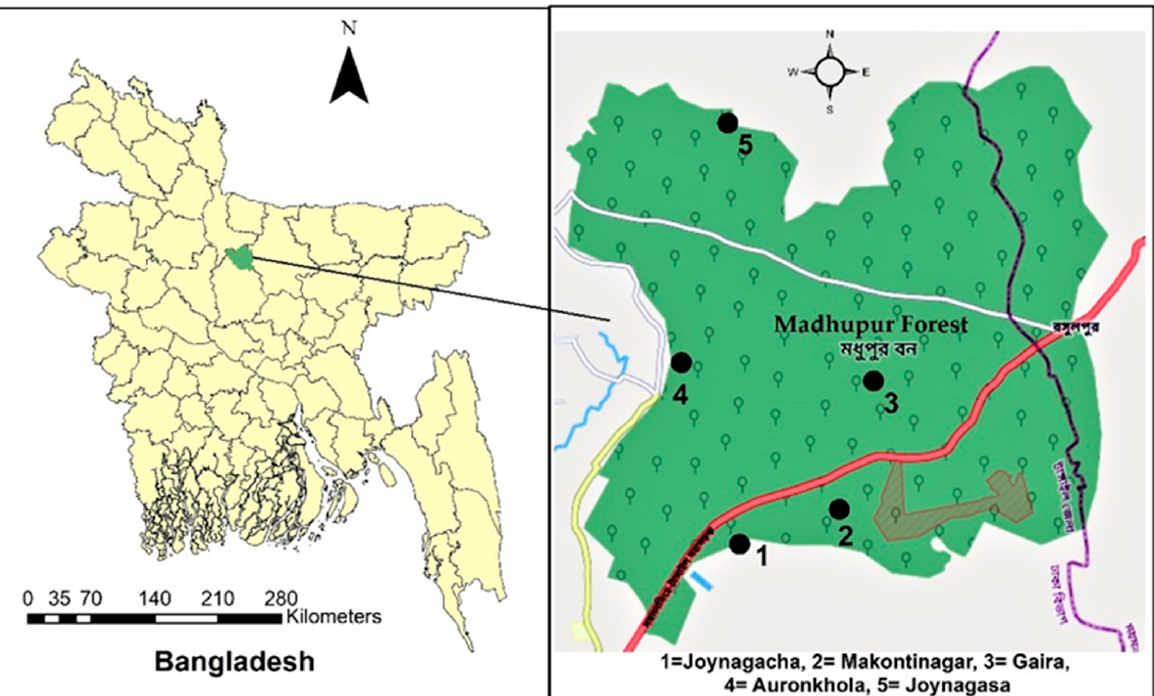
Figure 2. Study area map showing different villages of Madhupur tract and